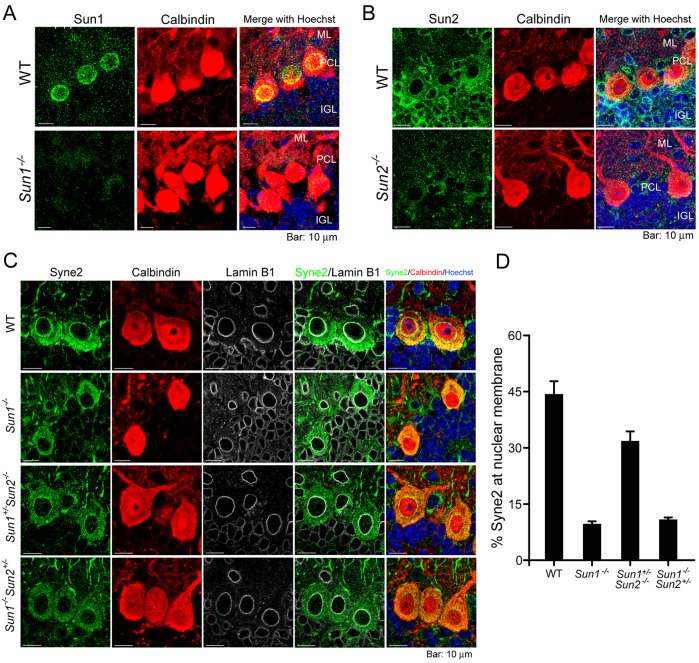
Sun1 recruits Syne2 to the nuclear membrane. (A) Expression and localization of Sun1 (green) in 14-day-old mouse cerebellum. The antibody against Sun1 specifically stained the nuclear rim of Purkinje cells. Parallel immunohistochemical staining of Sun1 in Sun1−/− cerebellum was used as a negative control. (B) Expression and localization of Sun2 (green) in 14-day-old mouse cerebellum by immunohistochemical staining. Parallel immunostaining of Sun2 in Sun2−/− cerebellum was used as a negative control. DNA was stained by Hoechst33342 (blue). ML, molecular layer; PCL, Purkinje cell layer; IGL, inner granule layer. (C) Expression and localization of Syne2 (green) in 14-day-old mouse cerebellum by immunofluorescent staining using paraffin-embedded tissue sections. Calbindin (red) and lamin B1 (gray) were co-immunostained to mark Purkinje cells and the nuclear membrane, respectively. (D) Percentage of Syne2 at the nuclear membrane. Intensities of fluorescence of Syne2 at the (nuclear membrane)/(total cells) were quantified by ImageJ. Eight to ten cells were quantified for each genotype. Mean±s.e.m. Scale bars: 10 μm.